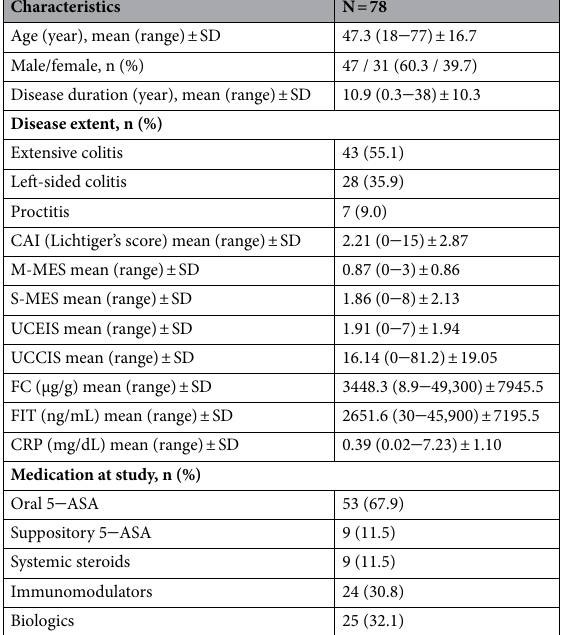
Table 1. Patient characteristics. CAI Clinical activity index, S-MES Sum of Mayo endoscopic subscore, M-MES Maximum Mayo endoscopic subscore, UCEIS Ulcerative colitis endoscopic index of severity, UCCIS Ulcerative colitis colonoscopic index of severity, FC Fecal calprotectin, FIT Fecal immunochemical occult blood test, CRP C-reactive protein, 5-ASA 5-aminosalicylic acid.